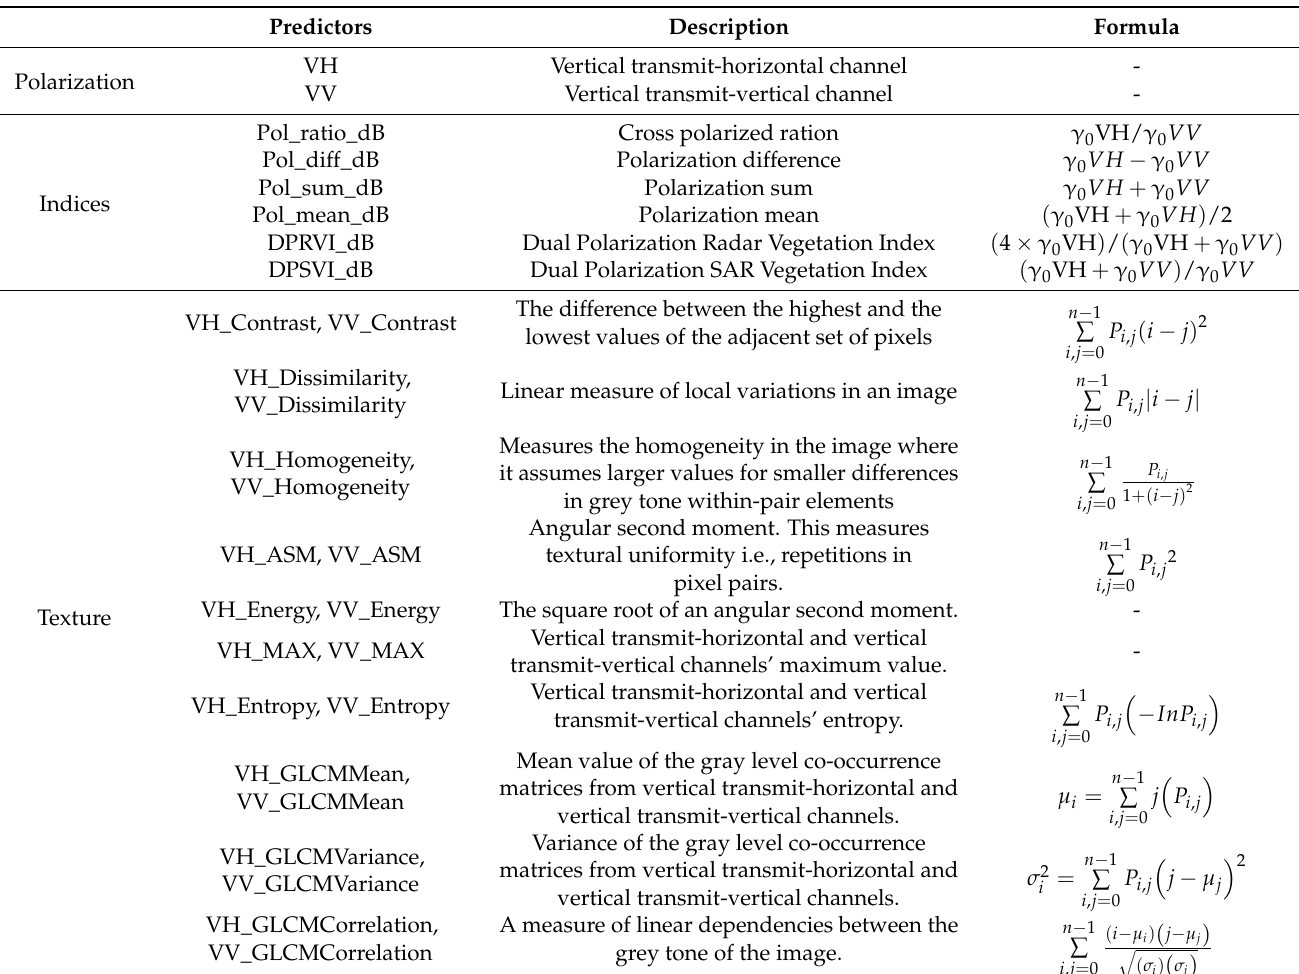
Table 3. List of Sentinel-1 predictors used for the aboveground biomass (AGB) modelling ( γ 0 represents the terrain-flattened gamma naught values). Description